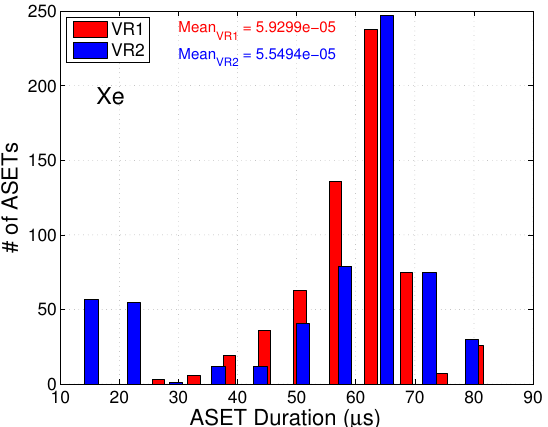
Figure 7. Measured number of ASETs versus ASETs duration for VR1 and VR2 circuits when exposed to Krypton.